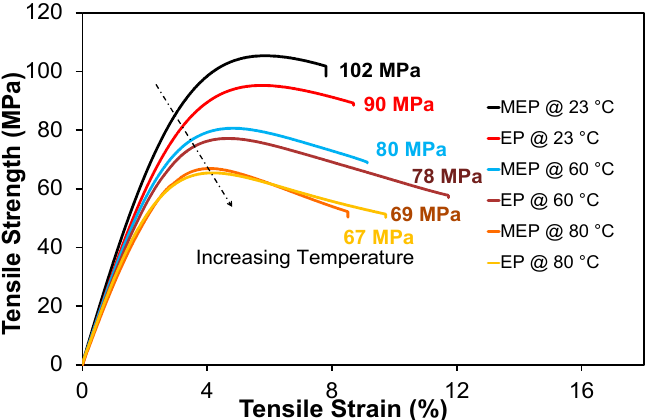
Figure 11. Effect of temperature on the stress–strain curve for the anhydride-based reference (EP) and modified epoxy (MEP) systems. At 23 °C, 60 °C, and 80 °C.